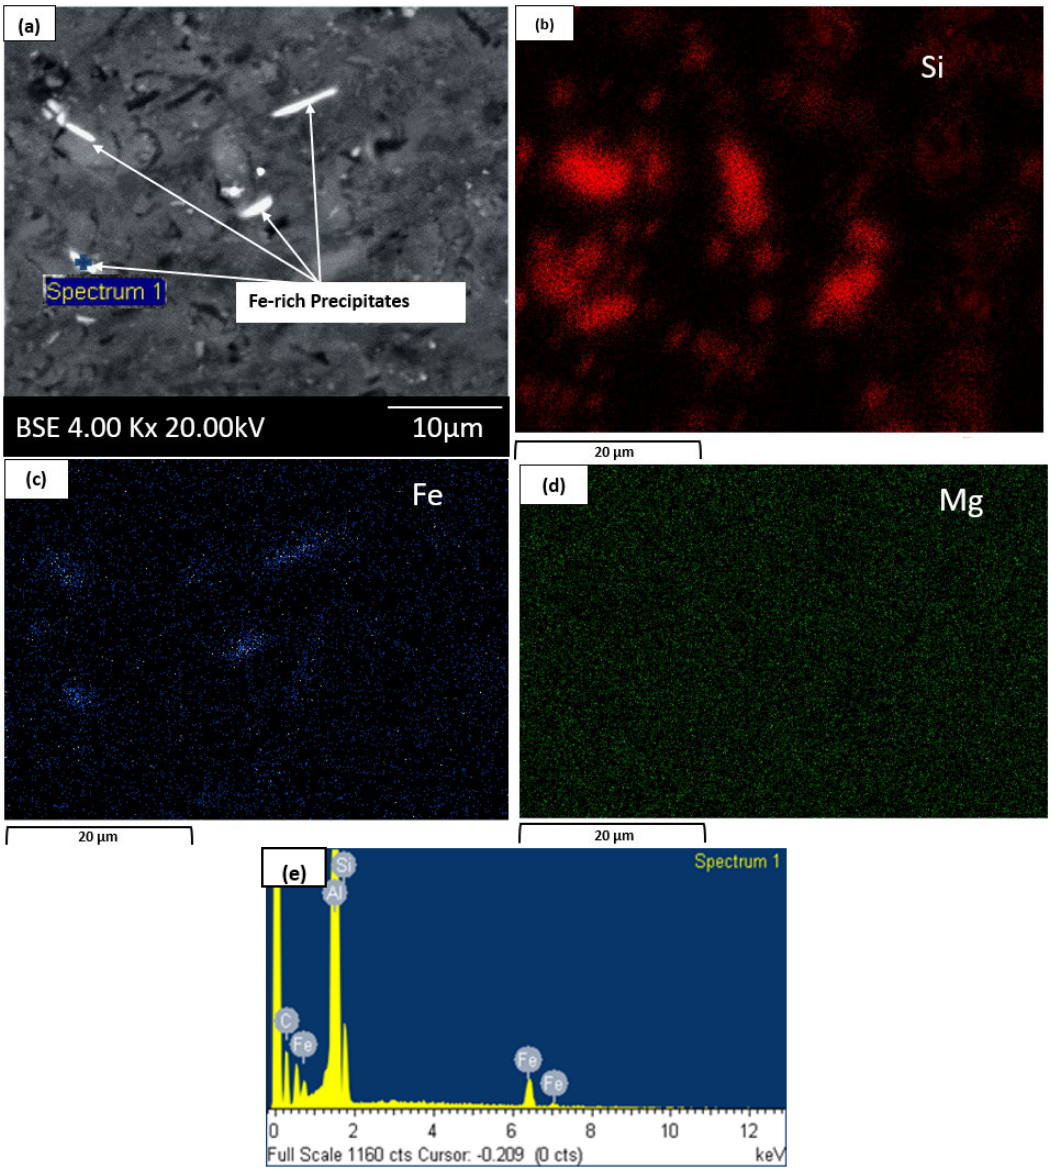
Figure 4. EDS analysis of specimens ST at 540 °C for 6 h. ( a ) SEM image of Al-Si-Fe precipitate and corresponding EDS maps of ( b ) Si; ( c ) Fe; ( d ) Mg ( e ) spot analysis spectrum.